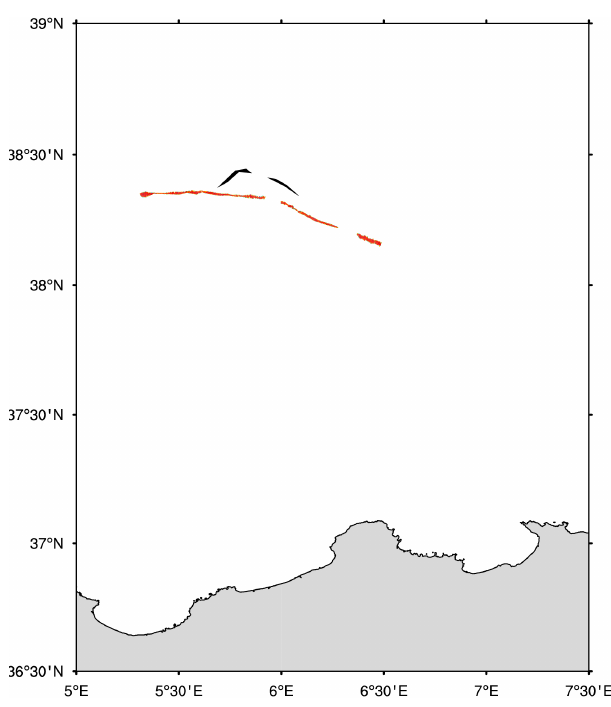
Fig. 10. The slick observed by SAR (red) on 6 August 2008 at 09:51UTC (post-processed data from the related ASAR image, wide swath mode, 400km, with a 150m spatial resolution) and the slick observed by the optical sensor (black) on 7 August at 10:50 UTC (post-processed data from the MODIS image).